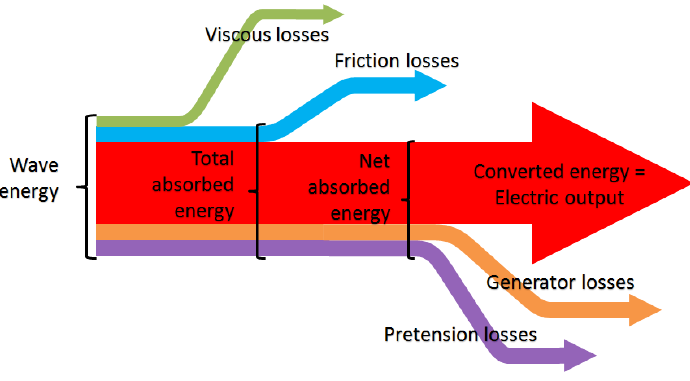
Figure 14. Assumed energy flow and associated definitions for the laboratory